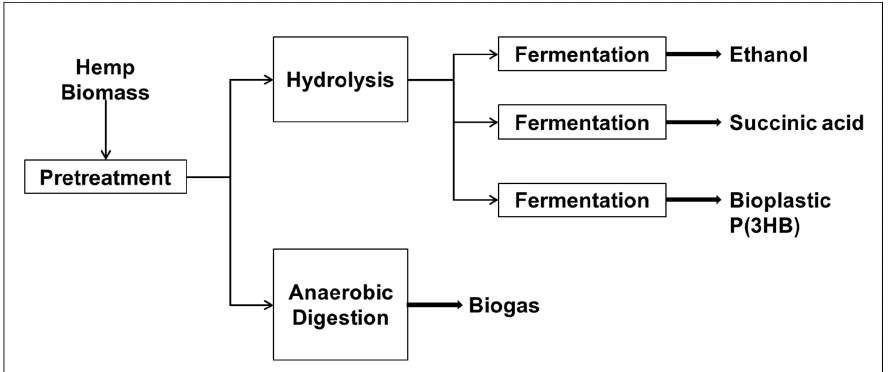
Figure 4. Reported bioprocessing routes for industrial